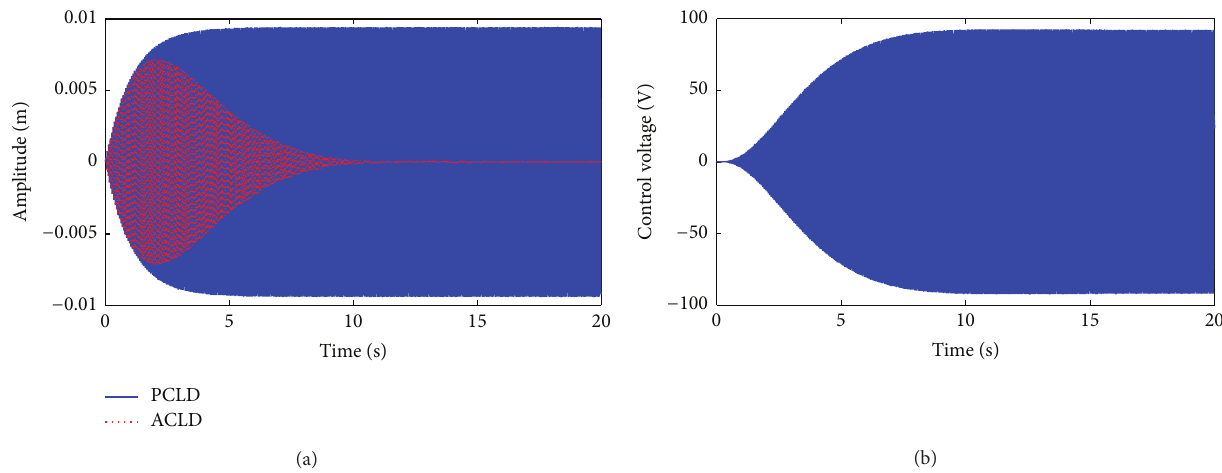
Figure 7: The displacement, control voltage for a single frequency harmonic disturbance using the adaptive filtered-reference LMS feedforward control: (a) the displacement response, (b) the control voltage.